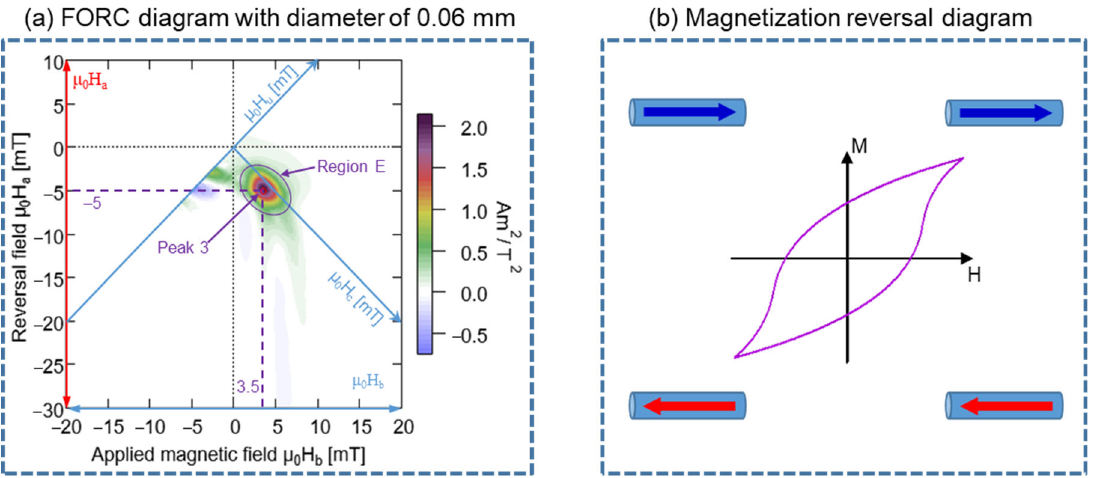
Figure 12. ( a ) FORC diagram of 0.06 mm-diameter Wiegand wire. ( b ) Magnetization reversal diagram of minor loop.